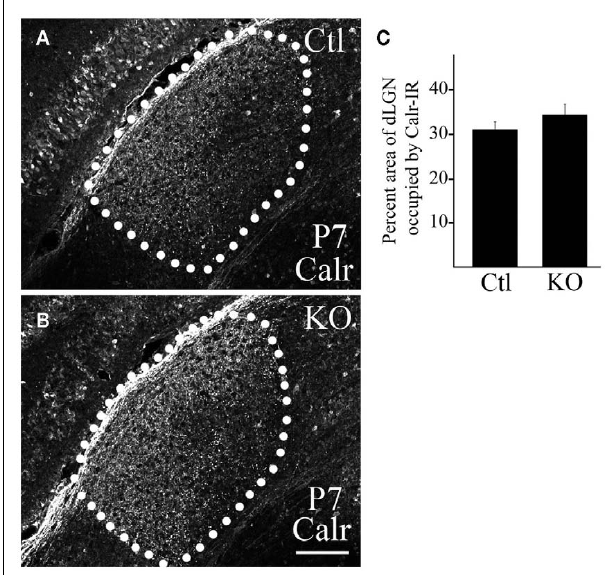
FIGURE 7 | Deletion of FGF22 does not delay targeting of dLGN-projecting RGC axons. Calr–IHC was used to assess the development of dLGN-projecting RGC axons in P7 control [Ctl; (A) ] and fgf22 − / − mutant [KO; (B) ] dLGN. dLGN are encircled by white dots. (C) The area of Calr-IR in control and mutant P7 dLGN was measured in ImageJ. No significant differences were detected in the percent area of dLGN innervated by Calr-expressing RGCs in P7 controls and mutants. Data are shown ± SEM; n = 4 mice. Scale bar = 125 μ